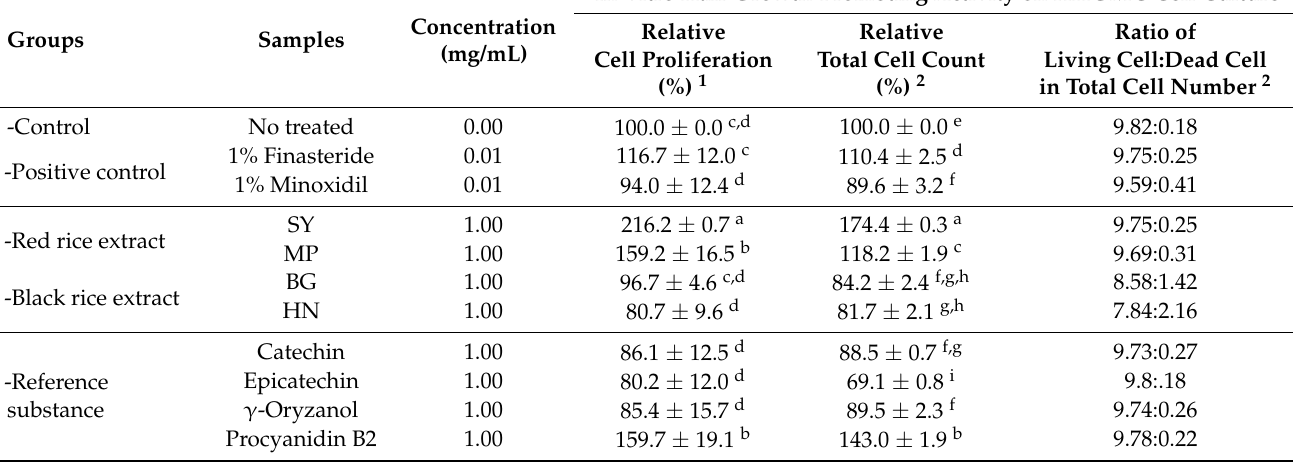
Table 2. In vitro hair growth-promoting activity of pigmented rice extracts on Human Hair Germinal Matrix Cells (HHGMC) with MTT and Trypan blue staining